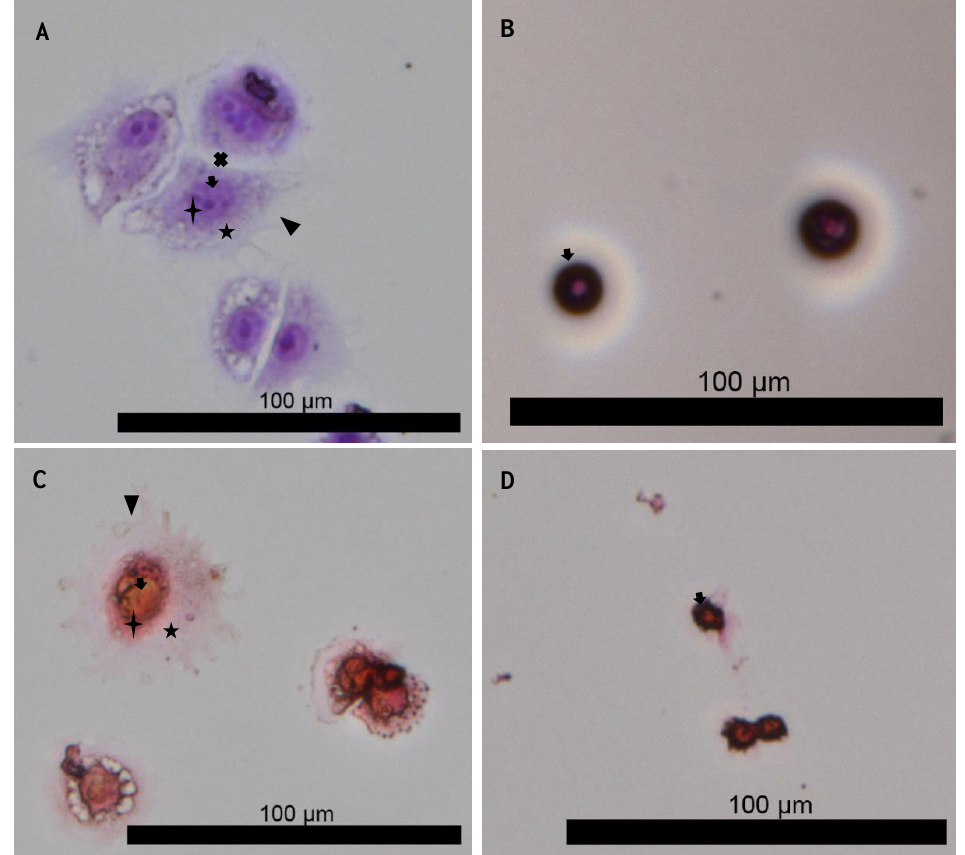
Figure 6. ( A , B ) Histological staining of GAG using DMMB for chondrons isolated from SA – GEL – GA showing the TM and IM, and ( B ) native chondrocytes at day 0 with smaller PCM and no TM or IM, respectively. ( C , D ) Histological staining of total collagen using Sirius red for chondrons isolated from SA – GEL – GA showing the PCM as the dark region around the cell and the TM and IM as the lighter regions further away, as well as that of a primary chondrocyte at day 0, respectively. chondrocyte, PCM, TM, IM, and lacunae.